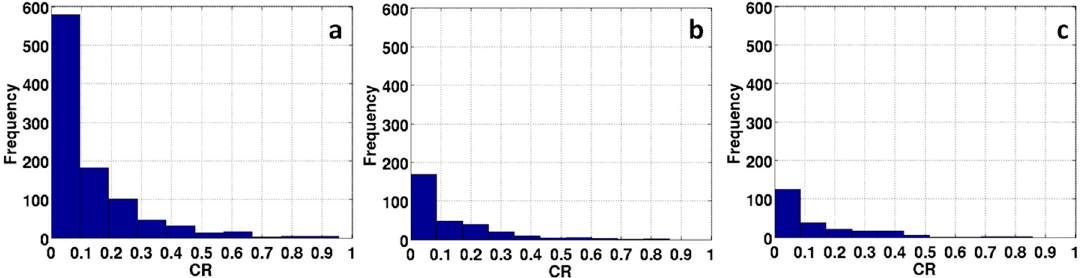
Figure 3. Distribution histograms for ( a ) training; ( b ) cross validation and ( c ) test of Haiti datasets used in the training phase.